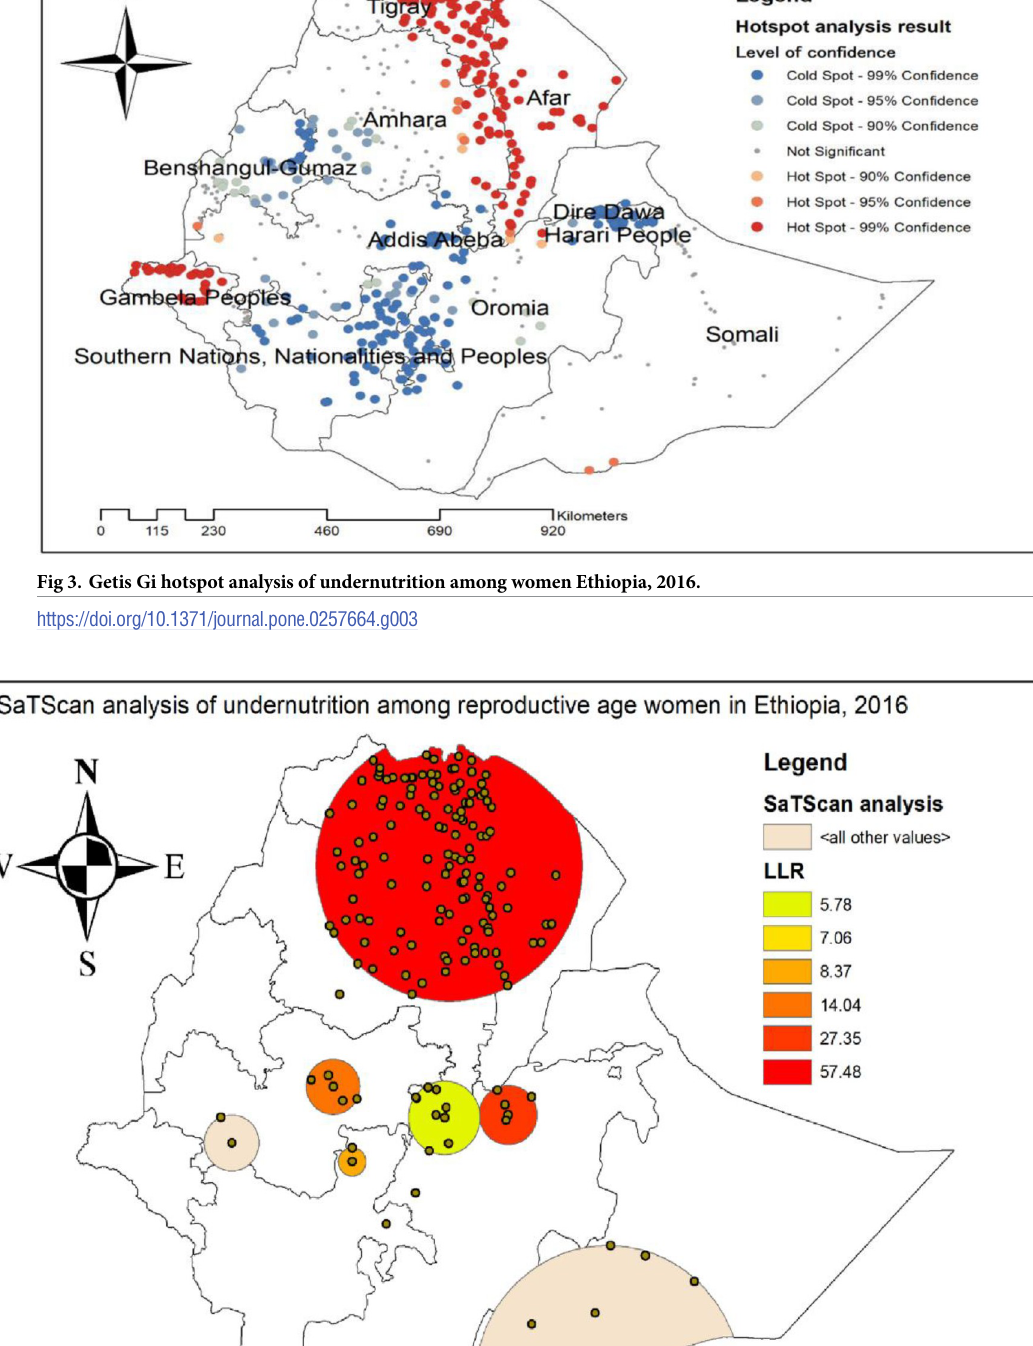
PLOS ONE | https://doi.org/10.1371/journal.pone.0257664 September 20,